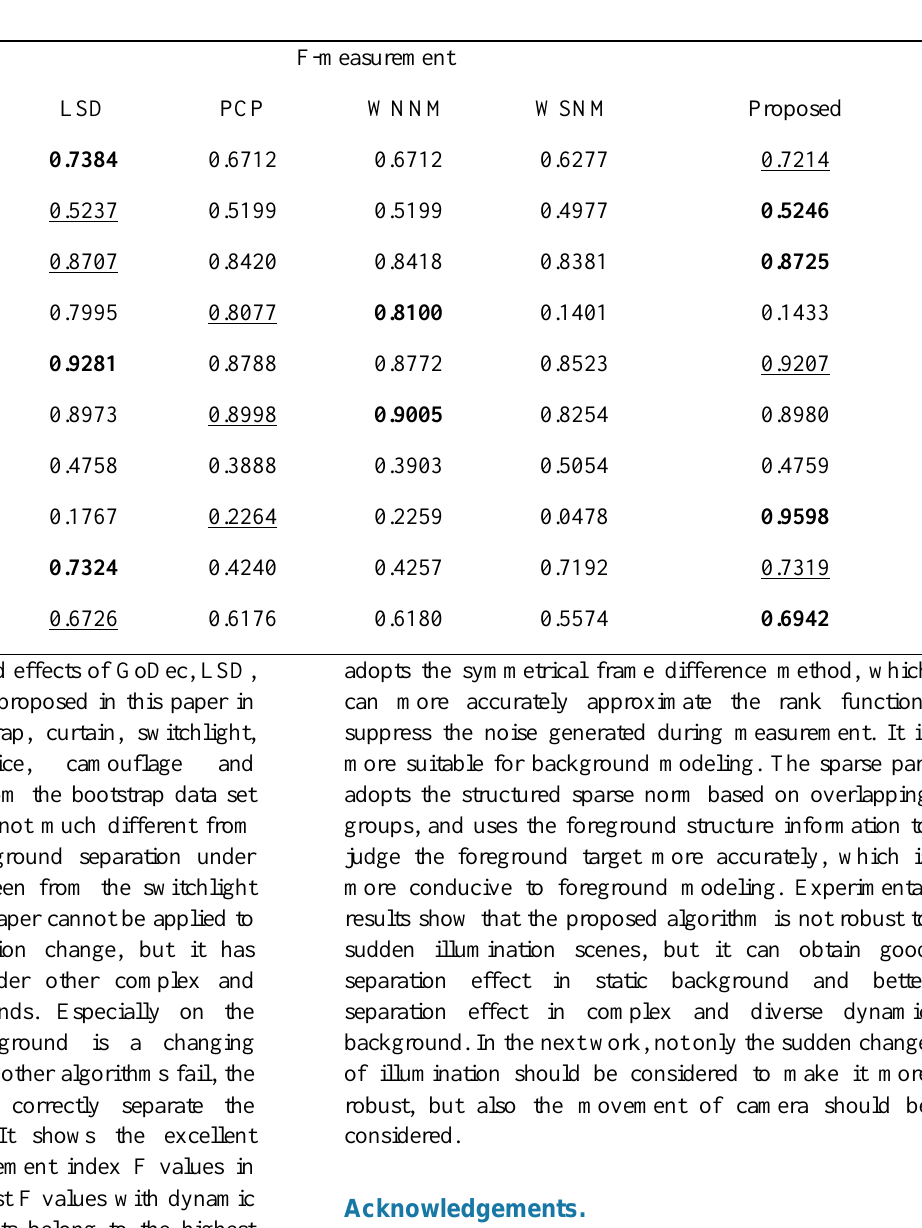
Table 2. F values with different